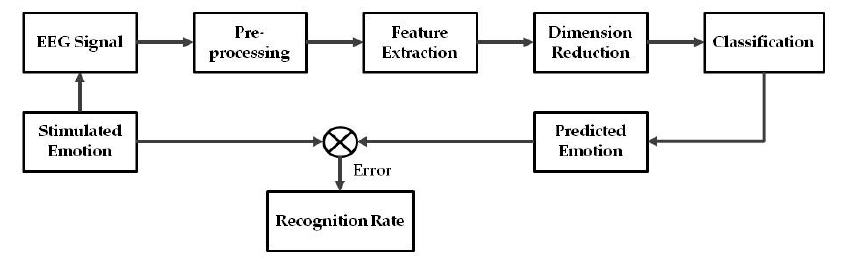
Figure 1. Block diagram of the EEG-based emotion recognition system.